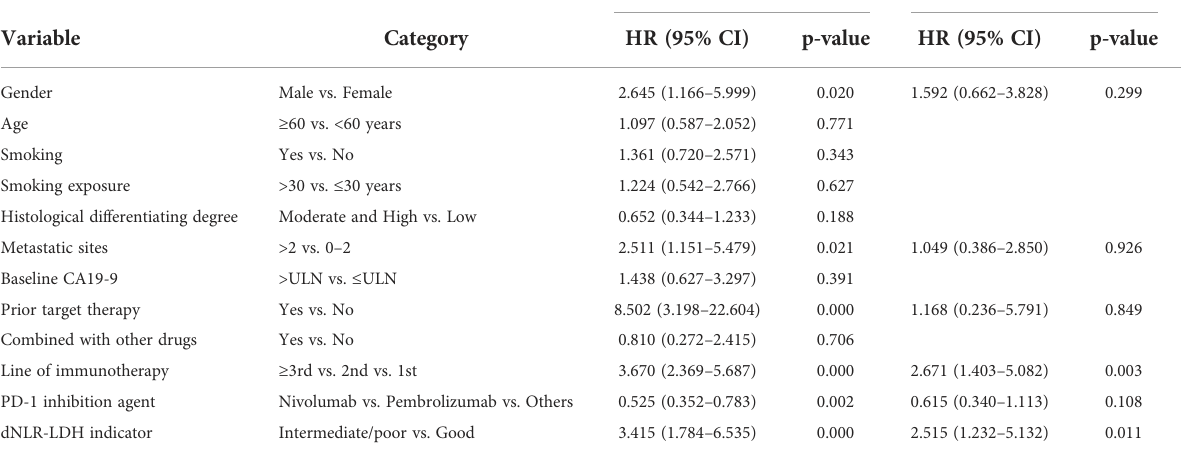
TABLE 3 Univariate and multivariate analysis for OS in PC patients treated with ICIs.